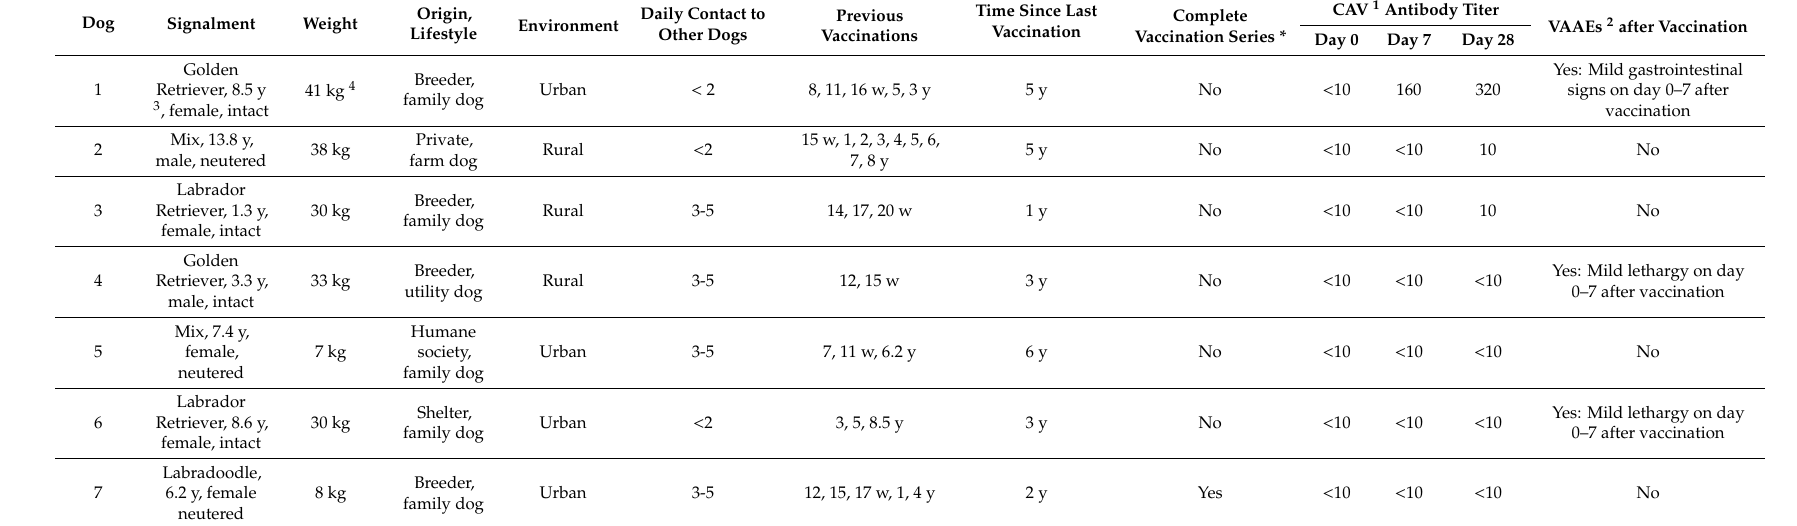
Table 4. Dogs lacking antibodies against canine adenovirus on day